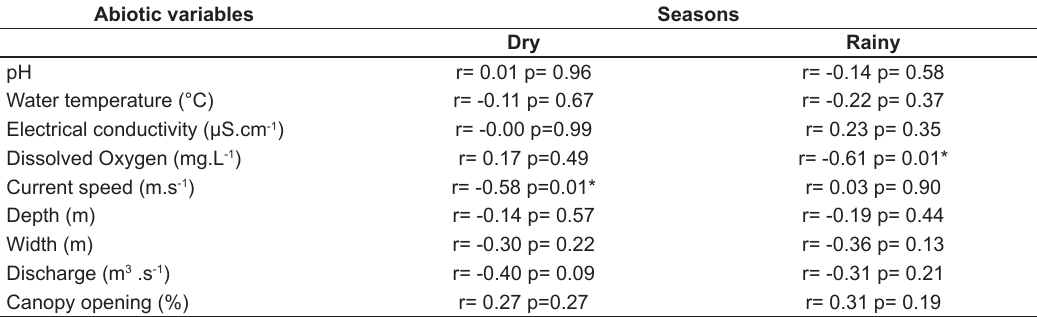
Table 2. Pearson correlations between the abiotic variables and the abundance of Phylloicus larvae in the streams in western Pará, Brazil.